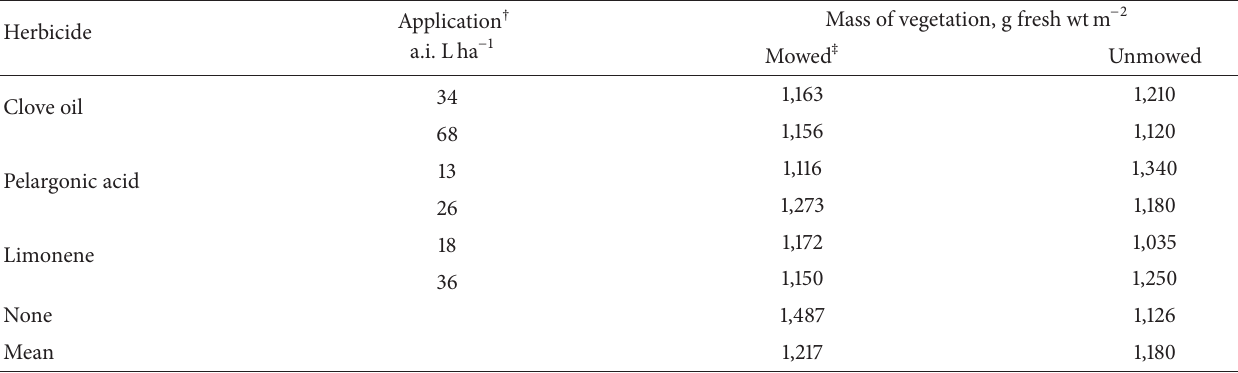
Table 11: Mass of vegetation harvested from roadside plots treated with alternative herbicides or with mowing (Roadside Experiment 1). Application Herbicide